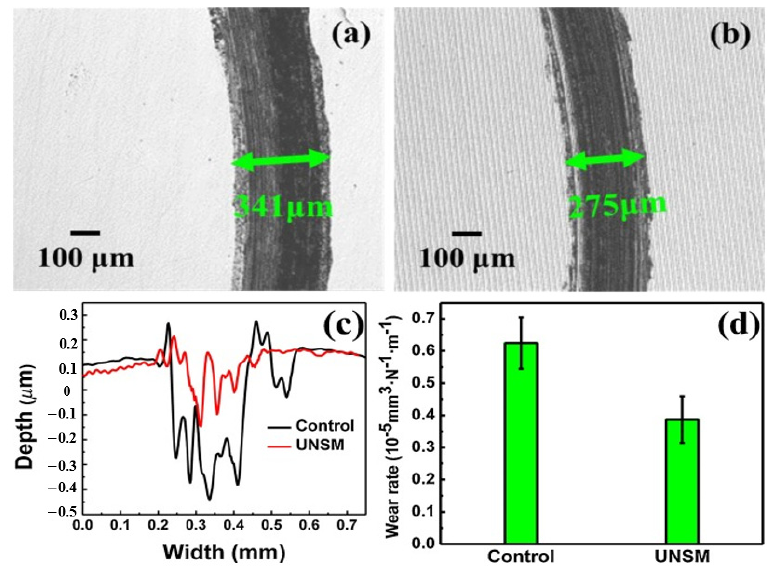
Figure 14. The wear track profiles of the ( a ) bulk and ( b ) UNSM 300 M martensitic ultra-high-strength steel, ( c ) wear depths, and ( d ) wear rates. Reprinted with permission from ref. [73]. Copyright 2020, Elsevier.